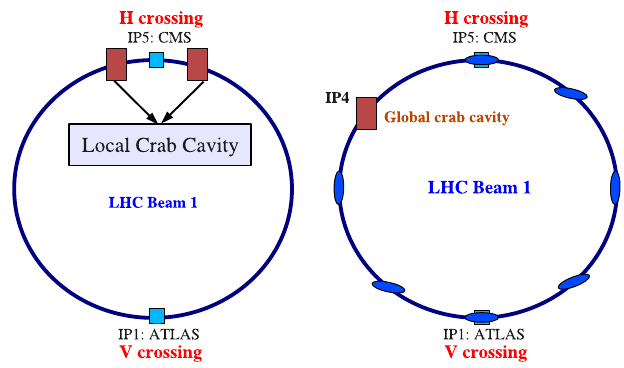
FIG. 1. (Color) Two local crab cavities in interaction region 5 (IR5) for LHC beam 1 which illustrates the local scheme (left) and one global crab cavity in IR4 for LHC beam 1 which illustrates the global scheme (right) ( single global scenario).